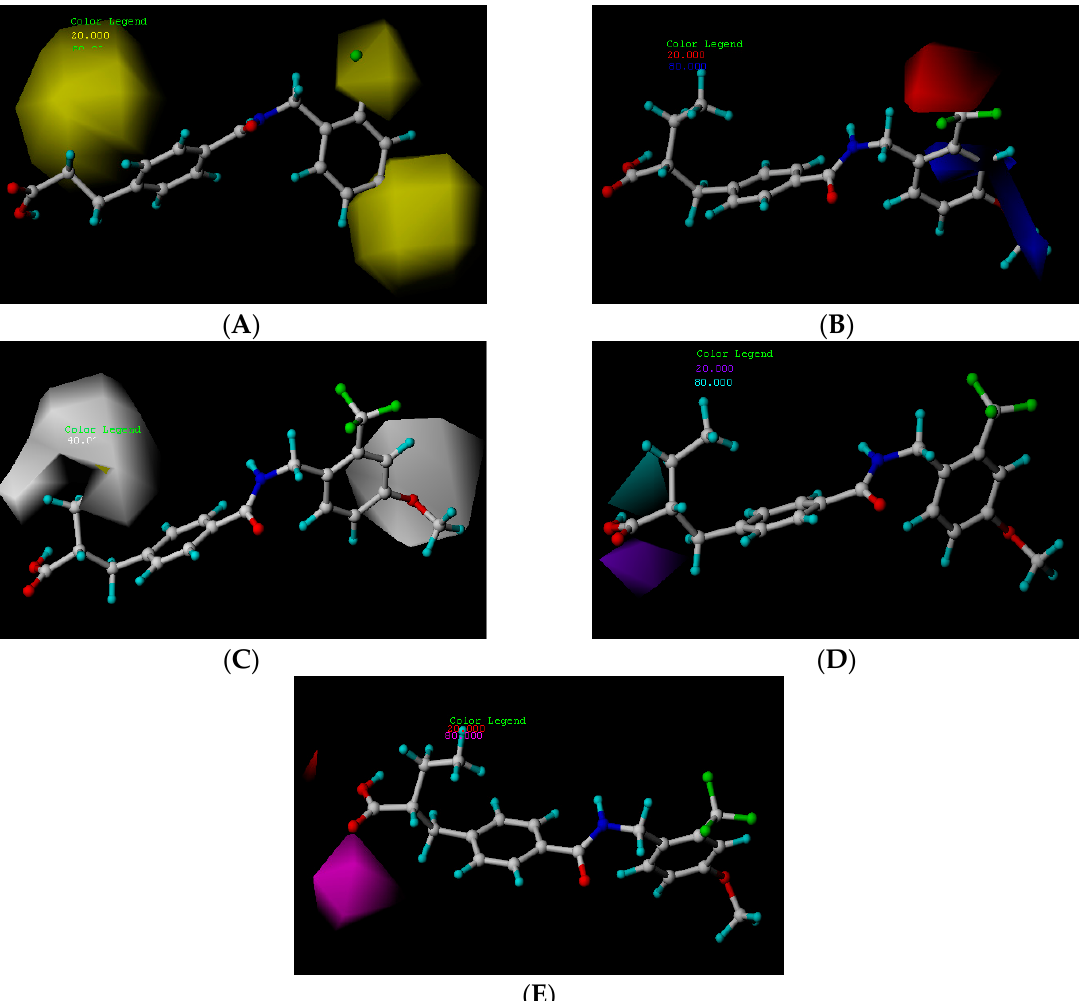
Figure 3. CoMSIA contour maps displayed with most potent compound, 24c . ( A ) CoMSIA steric contour map (green, favored; yellow, disfavored); ( B ) CoMSIA electrostatic contour map (blue, favored; red, disfavored); ( C ) CoMSIA hydrophobic contour map (yellow, favored; white, disfavored); ( D ) CoMSIA hydrogen donor contour map (cyan, favored; purple, disfavored); ( E ) CoMSIA hydrogen acceptor contour map (magenta, favored; red, disfavored).